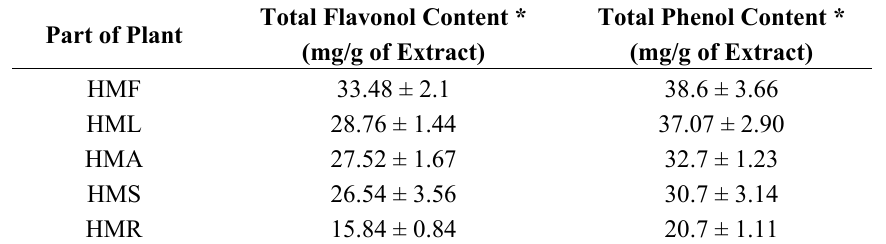
Table 1. Total flavonol and phenol content of different extracts of Hypericum mysorense